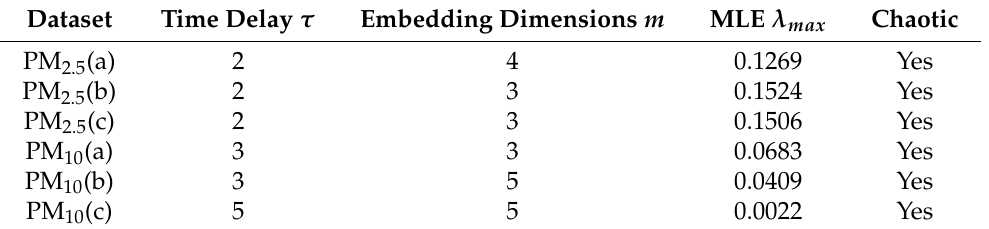
Figure 3. Process of calculating the time delay and embedding dimensions of the six air quality time series datasets. Table 1. The results of the time delay, embedding dimensions, and MLE of the six air quality time series datasets for